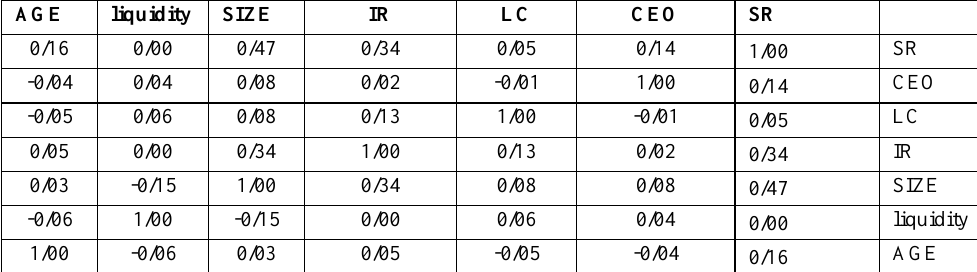
Table 4. Correlation results between